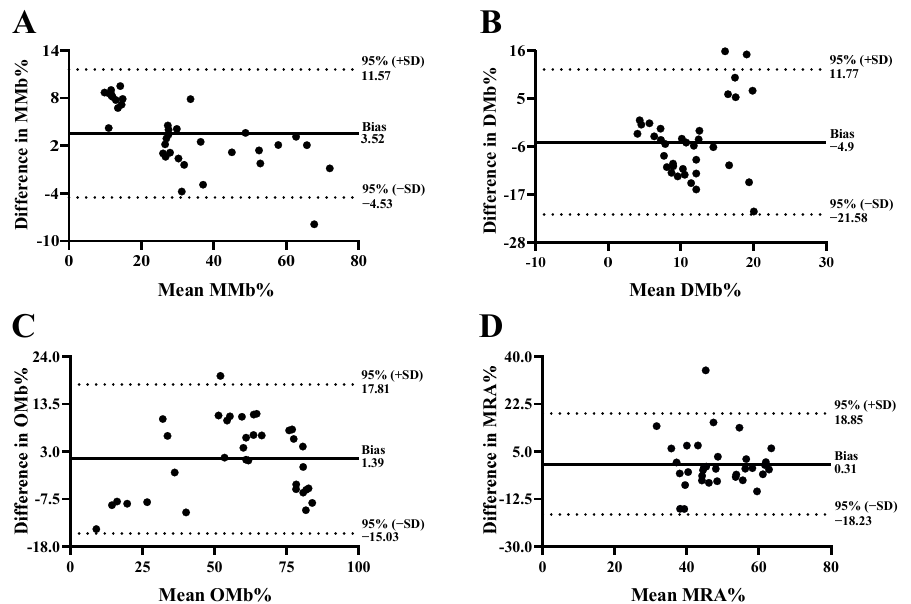
Figure 6. Bland-Altman limits of agreement of metmyoglobin% (MMb%; ( A )), deoxymyoglobin% (DMb%; ( B )), oxymyoglobin% (OMb%; ( C )), and metmyoglobin reducing ability% (MRA%; ( D )) values obtained from beef steaks using Spectro 1 and MiniScan.